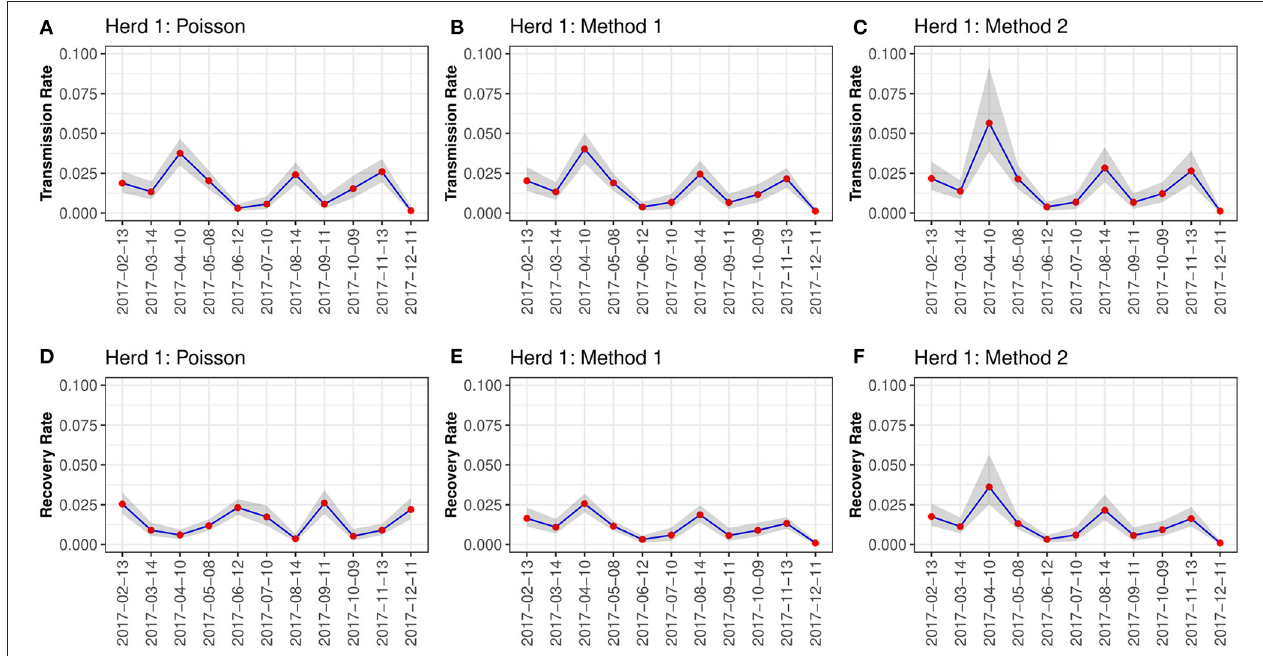
FIGURE 2 | Rates for Herd 1. This figure shows the estimated transmission and recovery rates for Corynebacterium spp. over time during the 12-mo sampling period for herd 1 in this study. Three methods were used to calculate the estimates; Poisson regression (A,D) , Method 1 (B,E) , and Method 2 (C,F) .